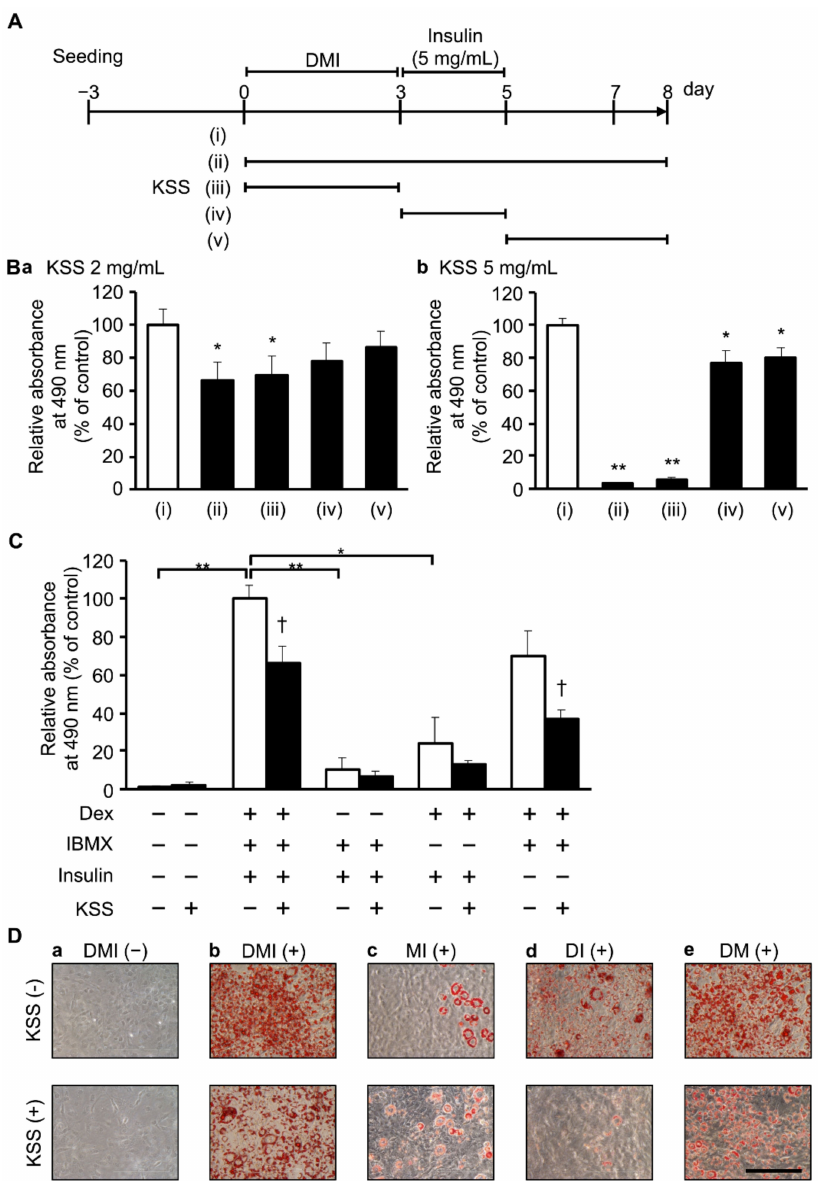
Figure 5. KSS inhibits early di ff erentiation into adipocytes through the inhibition of Dex action. ( A ) 3T3-L1 cell di ff erentiation stage and KSS administration time are shown. (i) No KSS administration, (ii) 0–8 days, (iii) 0–3 days (early-stage), (iv) 3–5 days (middle-stage), and (v) 5–8 days (late-stage). ( B ) KSS was administered at each di ff erentiation stage. As in Figure 1, the amount of lipid accumulated at 8 days is measured and shown as relative absorbance. ( Ba ) KSS (2 mg / mL), ( Bb ) KSS (5 mg / mL). ( C ) 3T3-L1 cells were cultured for 3 days in the presence of two of the three types of di ff erentiation inducers (1 µ M Dex, 0.5 mM IBMX, and 10 µ g / mL insulin). KSS (2 mg / mL) was administered for 8 days from the start of di ff erentiation. The amount of lipid accumulated was measured as in Figure 1, and the relative absorbance is shown for the DMI method and KSS (-). ( D ) Oil-Red-O stained images of the cells cultured for 8 days. Upper: KSS (-), Lower: KSS ( + ), ( Da ) DMI (-), ( Db ) DMI ( + ), ( Dc ) MI ( + ), ( Dd ) DI ( + ), and ( De ) DM ( + ). The scale bar indicates 200 µ m. Data are shown as mean ± standard deviation ( n = 3). * p < 0.05 and ** p < 0.01 vs. (i) KSS (-) administration ( B ) or DMI method and KSS (-) ( C ). † p < 0.05 vs. KSS (-)